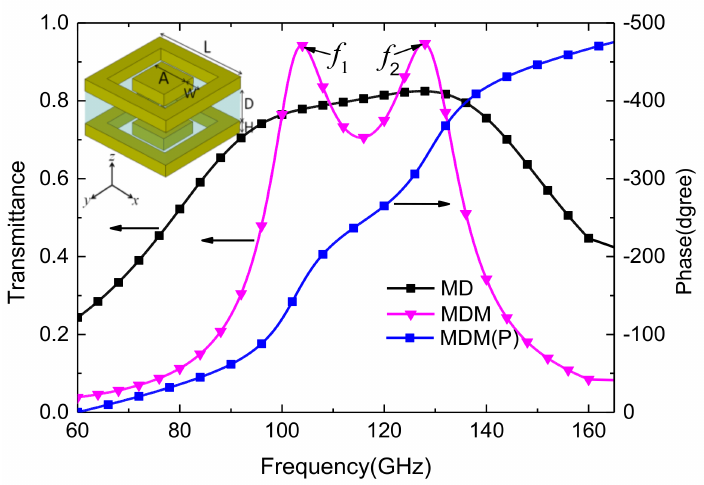
Figure 1. Transmission spectra thourgh the metal − dielectric (MD) and metal − dielectric − metal (MDM) structures for a normally incident plane wave.